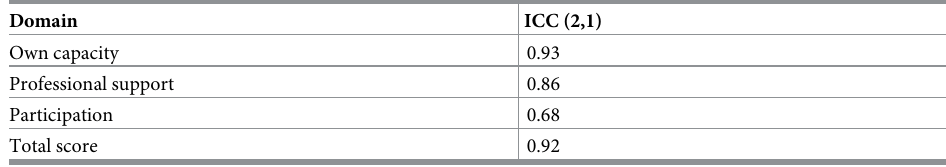
Table 5. Test-retest reliability for the domains of the CEQ, the quadratic weighted index of agreement (weighted